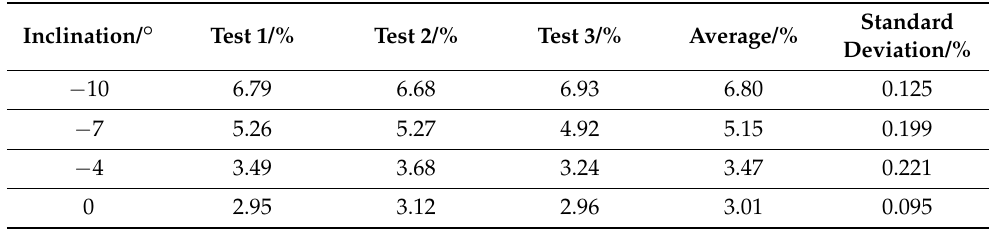
Figure 14. Schematic diagram of the test plan. Table 7. Cleaning loss without automatic leveling control system.